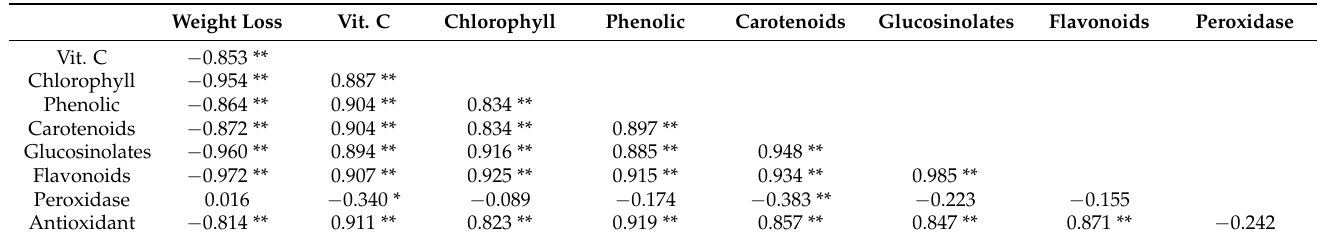
Table 1. Pearson’s correlation among the evaluated parameters of broccoli florets.